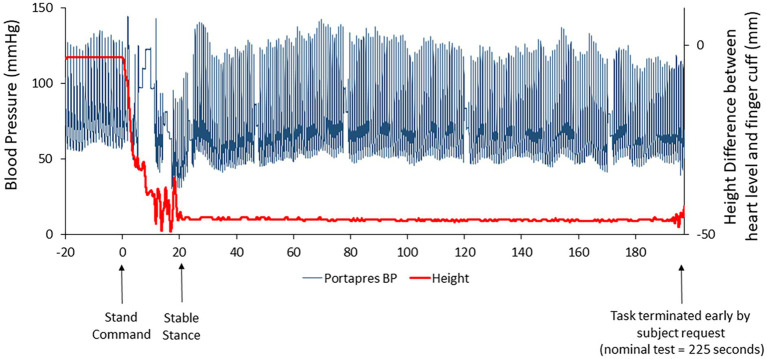
Beat-to-beat blood pressure tracing (raw data; blue line) in one subject who was unable to complete the stand test on R+0B. The red line represents the height correction sensor for the ambulatory blood pressure device (Portapres®) that was placed at heart level on the subject’s arm. The height correction is near “0” when the subject is prone but decreases when the subject is standing. Retrospective review of these data suggested that the subject was not hypotensive.